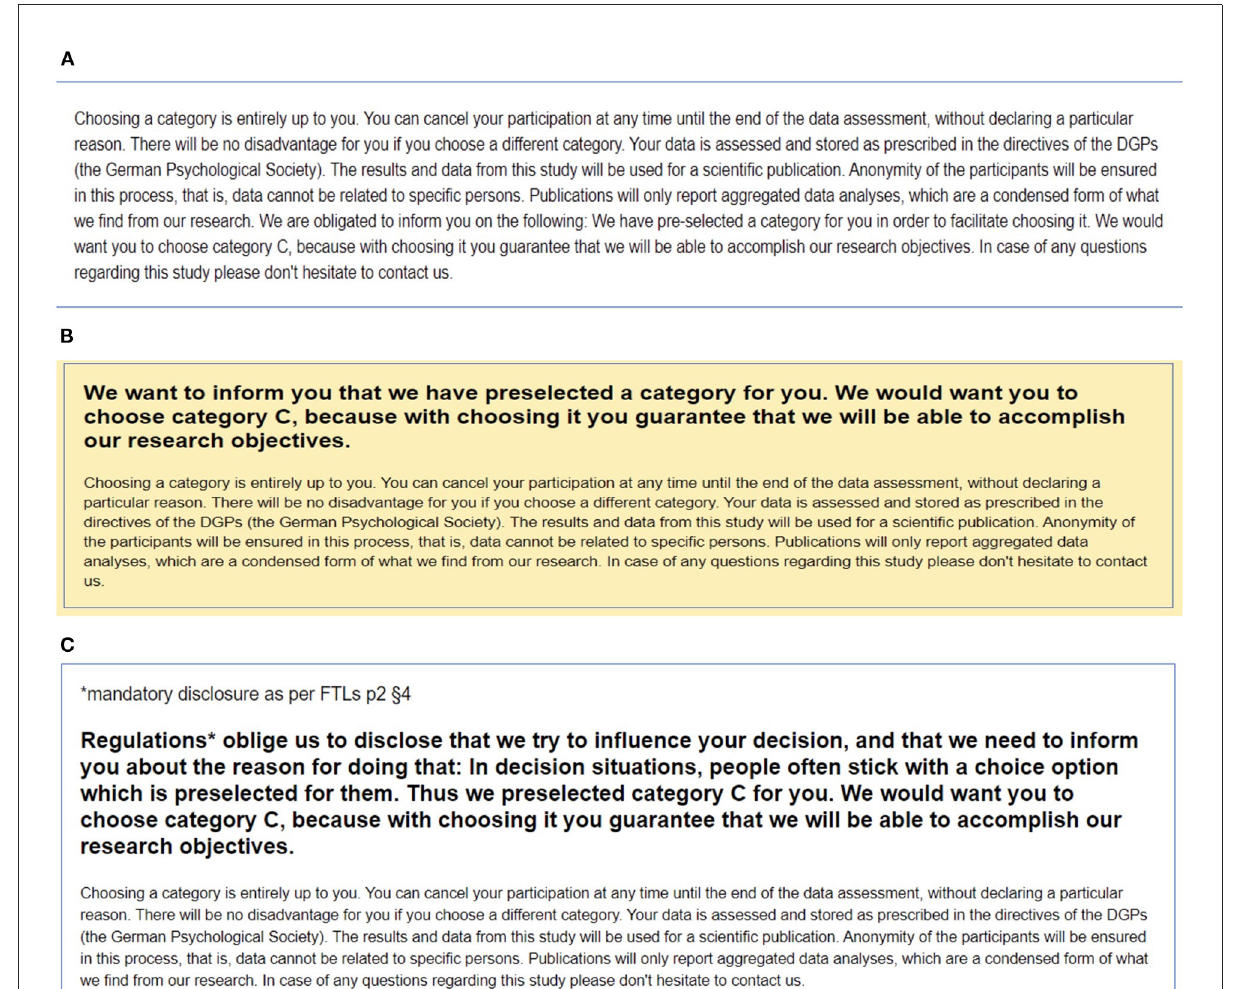
FIGURE1 Screenshots from the information disclosures in transparency conditions per experimental study. (A) Mandatory transparency condition Study 1. (B) Proactive transparency condition Study 1. (C) Mandatory transparency condition Study 2. (D) Proactive transparency condition Study 2.